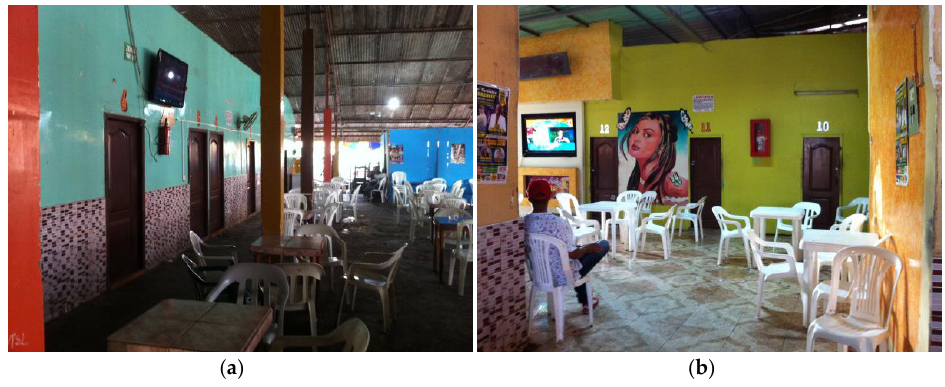
Figure 5. La Puente brothel in Machala, Ecuador. Photos by author.